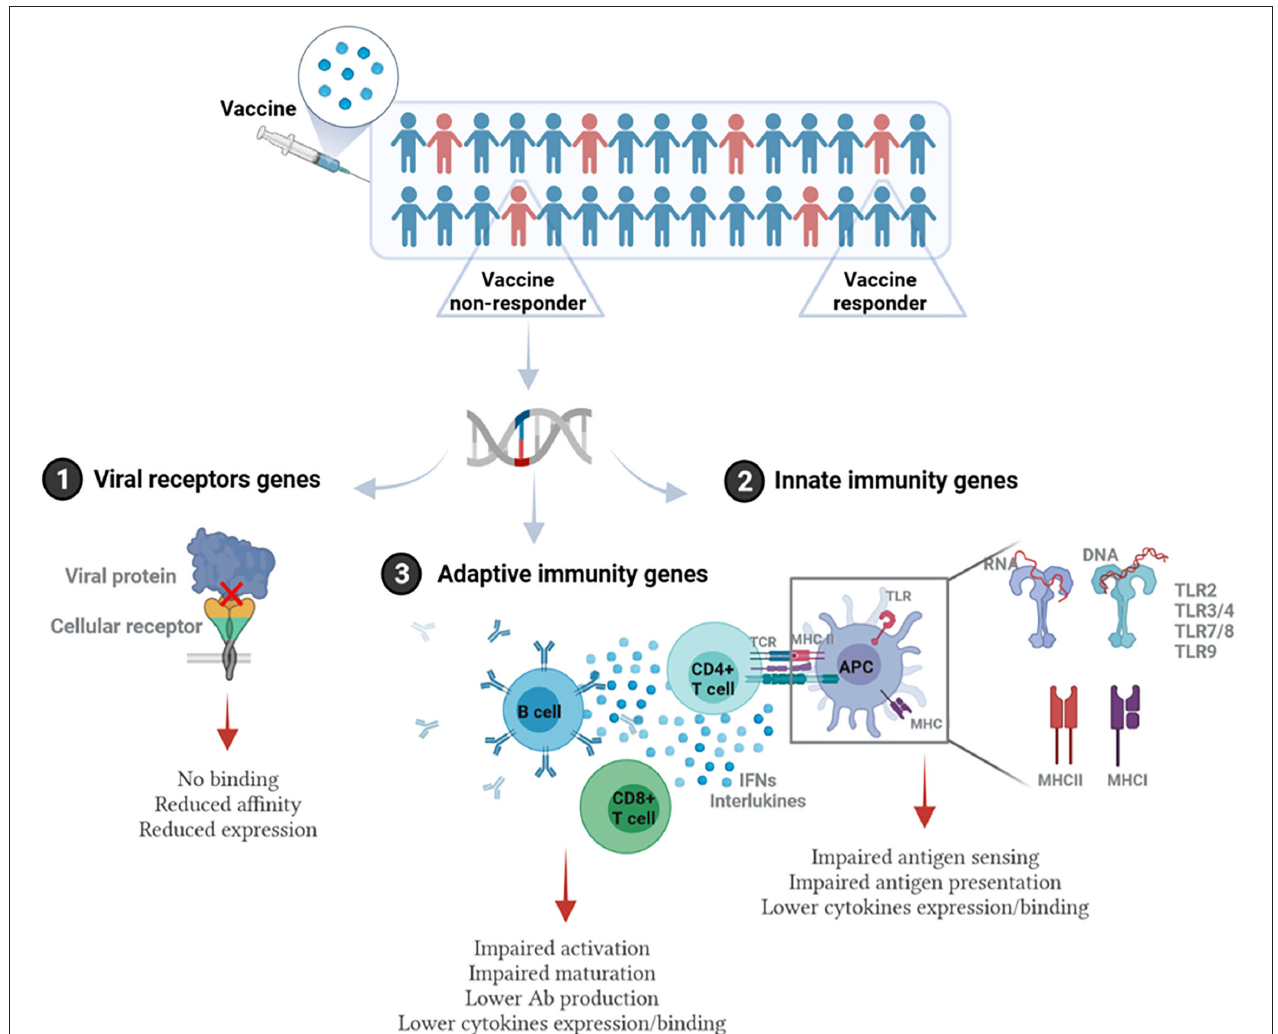
FIGURE 1 | Immunogenetic pathways involved in vaccine response. Individuals/populations with lower vaccine efficacy could carry genetic polymorphisms in: (1) Genes encoding viral receptors on the host cells. This could affect the binding affinity of viral antigen and cellular receptor, virus entry, or the level of receptor expression. (2) Genes related to the innate immunity. This includes genes encoding pathogen recognition receptors (PRRs) such as different types of TLRs, and MHC (HLA) genes that are essential for antigen presentation, as well as genes encoding cytokines and cytokine receptors. (3) Genes related to adaptive immune response such as T and B cell receptors, genes related to activation or differentiation of adaptive immune cells, and antibody production. This figure was generated using